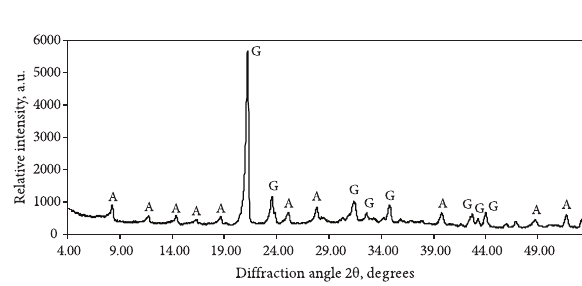
Fig. 3. X-ray of synthetic zeolite admixture: A – zeolite A; G – gypsite (Al(OH)